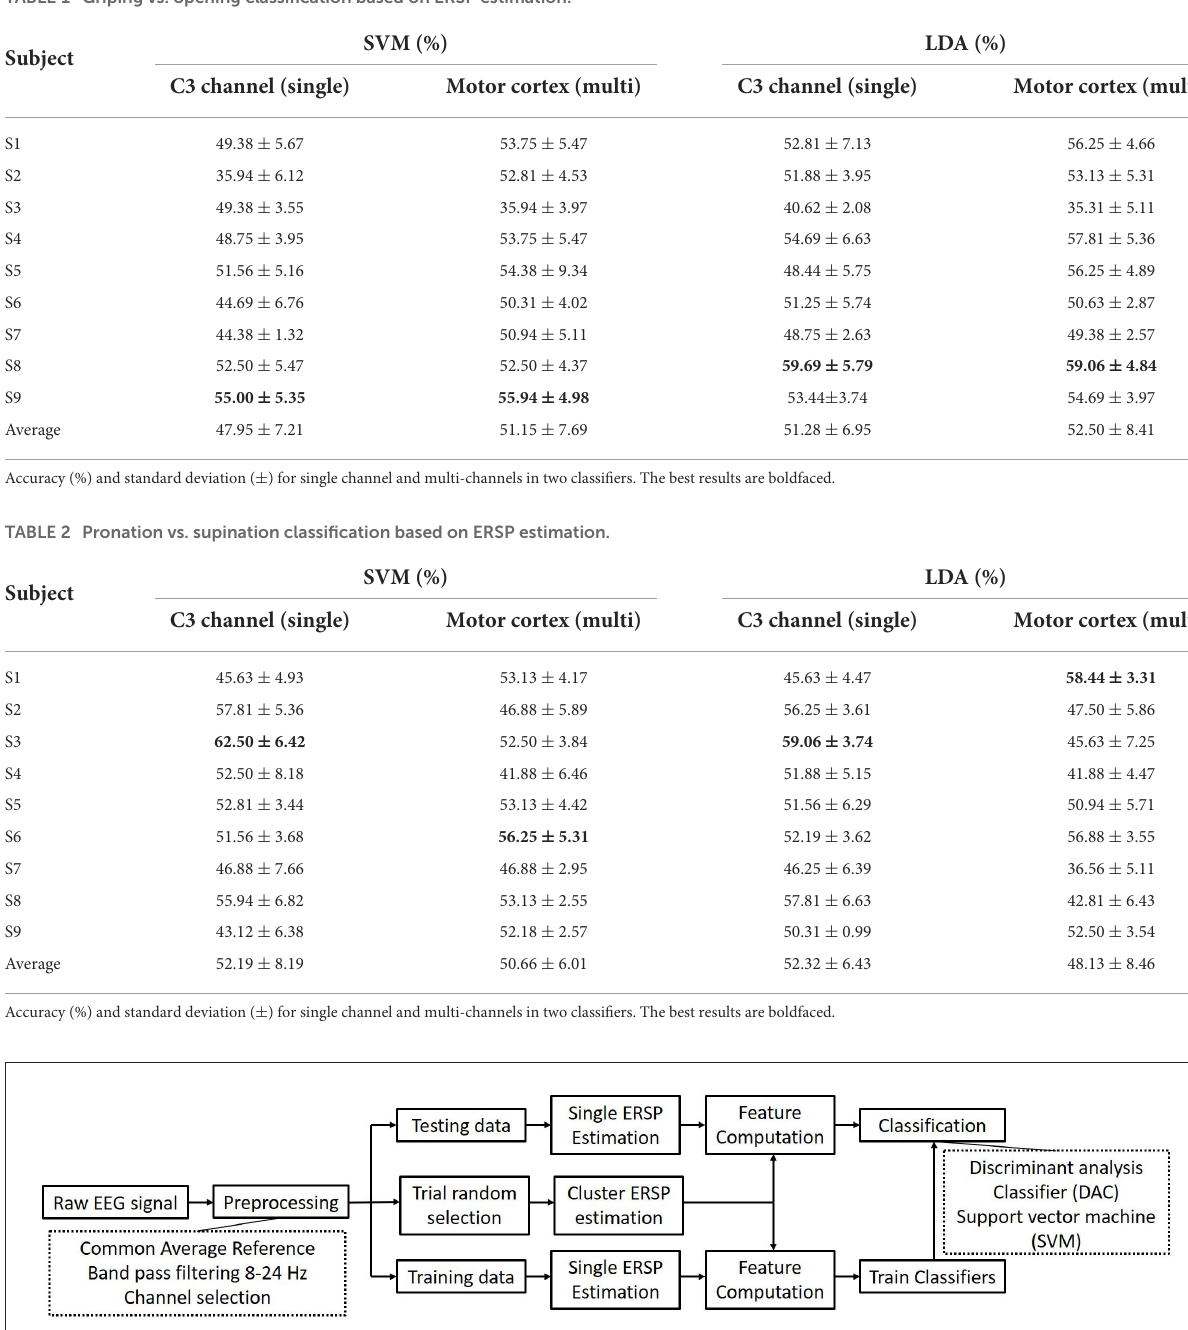
TABLE 1 Griping vs. opening classification based on ERSP estimation.